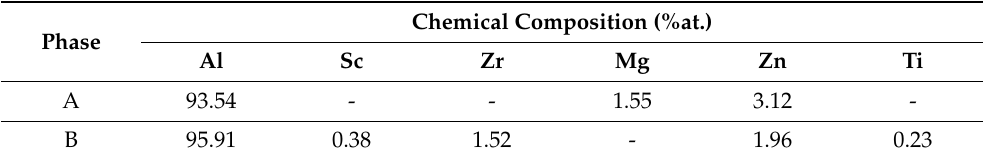
Table 3. EDS analysis of points A and B in Figure